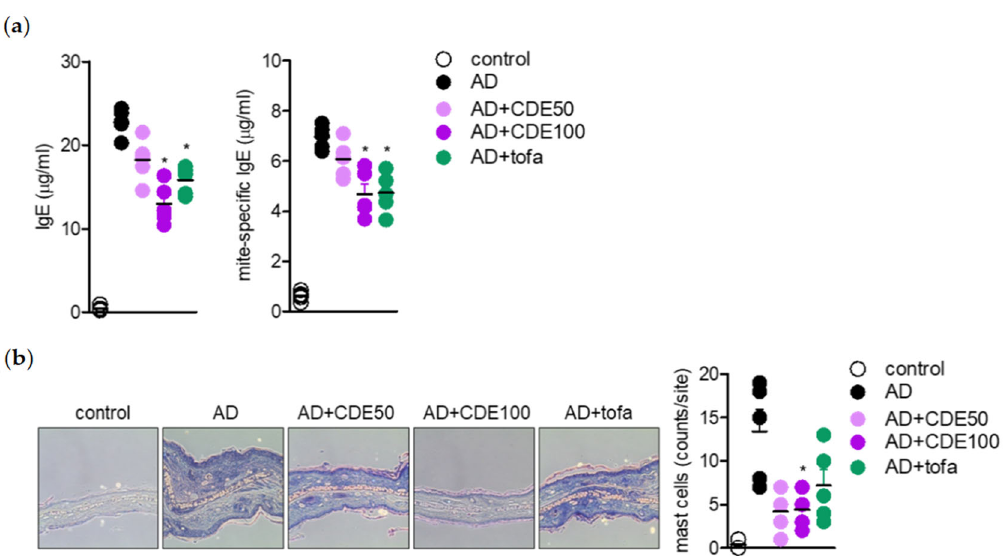
Figure 4. CDE reduces IgE production and mast cell infiltration in AD mice. ( a ) Levels of IgE and mite ‐ specific IgE were analyzed by ELISA in serum isolated on day 28 after induction. ( b ) Representative photos of sections for each group through toluidine blue staining and evaluation of the number of mast cell infiltration into the ear tissues of each group. Results are expressed as mean ± SEM of five mice. * p < 0.05, versus the AD group.